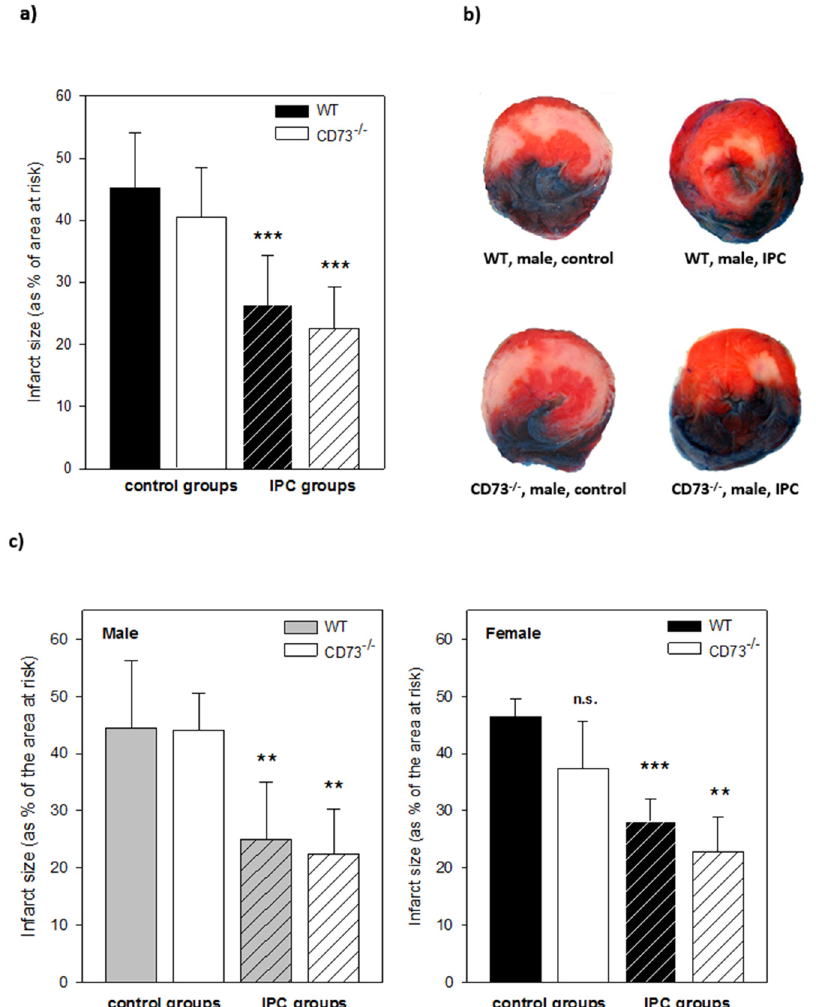
Fig 4. Infarct sizes in vivo open-chest model and sex differences. a) Infarct sizes in vivo in wild type and CD73 -/- mice. Ischemic preconditioning reduced infarct sizes in both IPC groups significantly compared to control groups. n = 12 – 13 per group, *** = p < 0.001 in comparison to the respective control group. b) Double staining of in vivo heart slices with Evans Blue (blue dye) and TTC (red dye) to differentiate between infarcted tissue (white), vital cardiomyocytes (red) and tissue outside of the AAR (blue). Exemplary heart slices of male wild type and CD73 -/- animals show less infarcted tissue in IPC groups compared to controls. c) Infarct sizes of wild type and CD73 -/- mice differentiated by sex: There were no significant differences between male and female mice concerning either control infarct sizes or cardioprotection by IPC. n = 5 – 7 per group, ** = p < 0.01, *** = p < 0.001 in comparison to the respective control